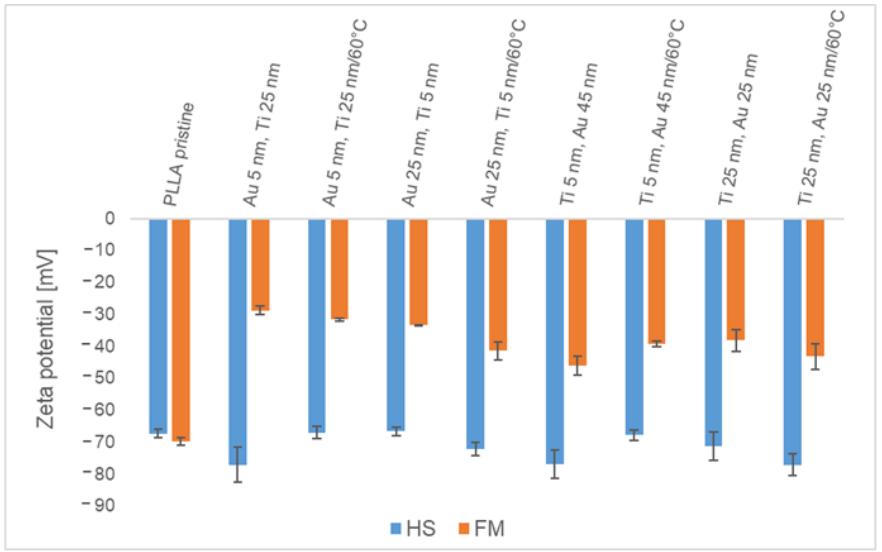
Figure 11. Zeta potential of sputtered samples with Au and Ti layers of different thicknesses and the same heated samples determined using the Helmholtz–Smoluchowski (HS) and Fairbrother–Mastins (FM) equations.